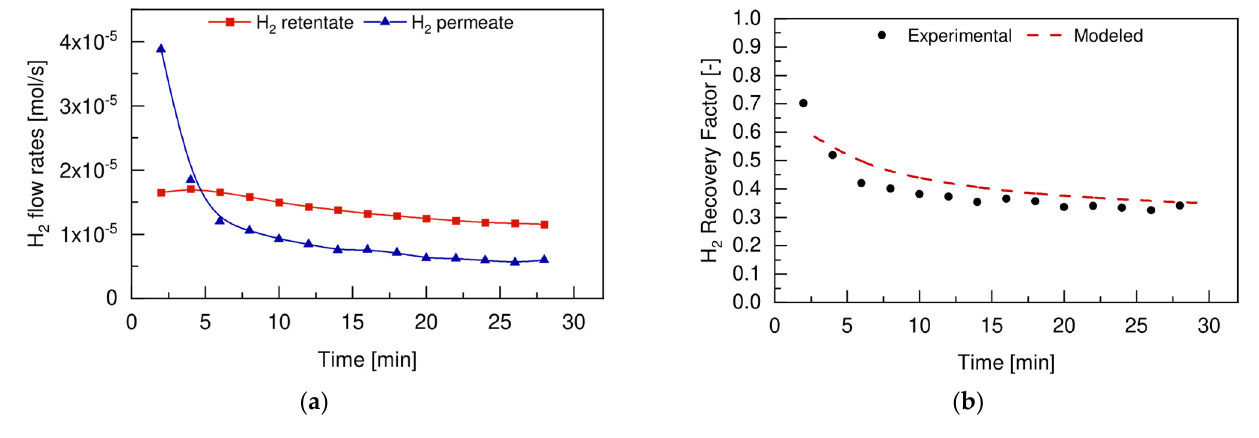
Figure 11. ( a ) Hydrogen flow rates measured in the retentate and permeate side of the FBMR and ( b ) the corresponding hydrogen recovery factor, measured at 500 °C, 2 bar, u 0 /u mf of 1.5, and with a feed composition of 30vol% C 3 H 8 -70vol% N 2 .